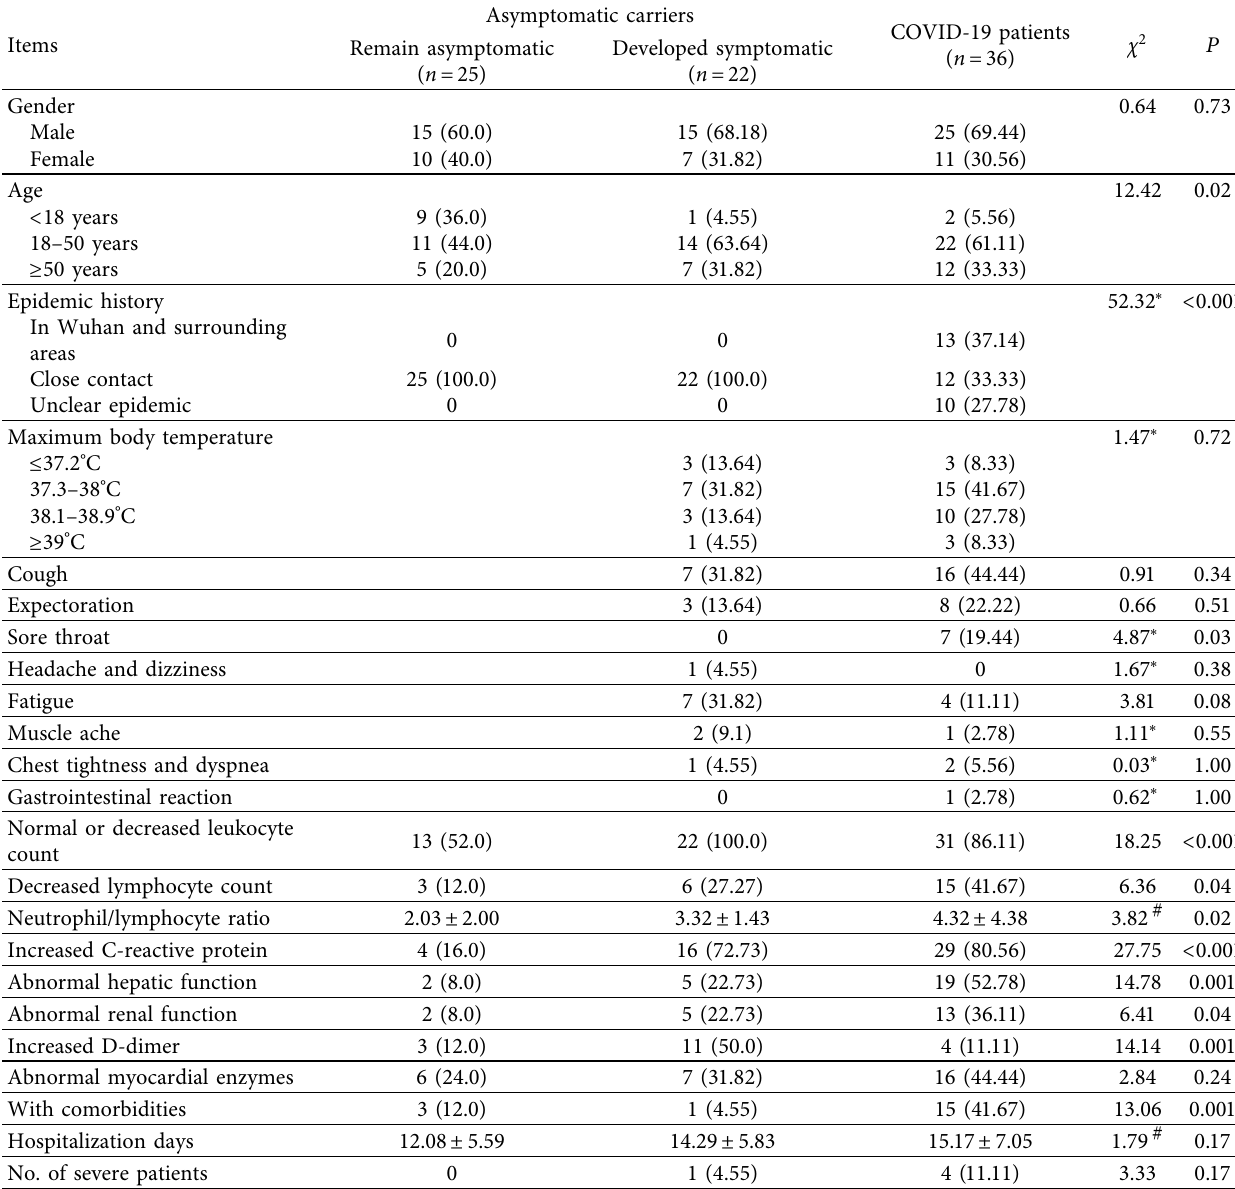
Table 1: Clinical data of the patients [ n